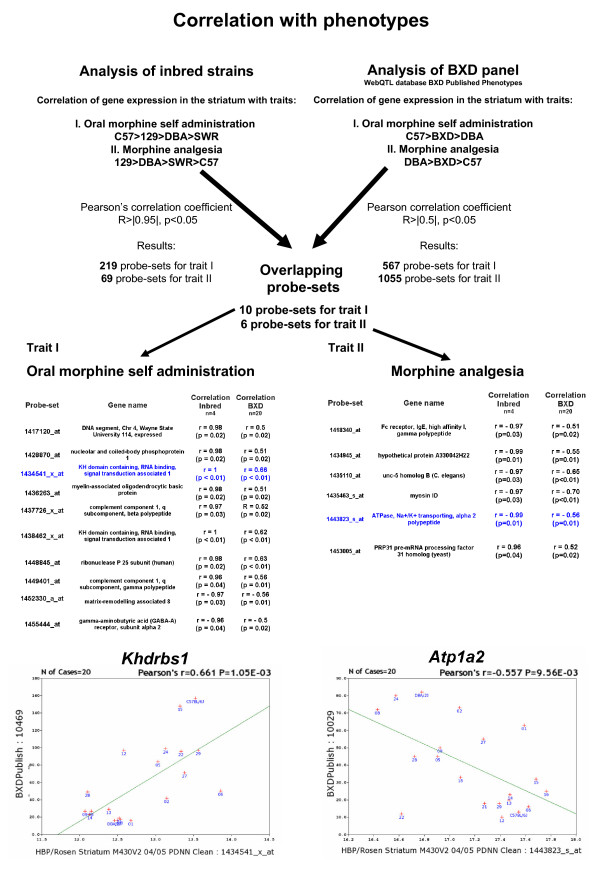
Correlation between opioid-related phenotypes and striatal gene expression. Comparison was performed using gene expression values of 1528 probe-sets significantly different between 129P3/J, DBA/2J, C57BL/6J and SWR/J strains [6]. Correlations between gene expression and morphine-related traits for RI BXD strains were computed using HBP/Rosen Striatum M430 v2.0 (Apr05) PDNN Clean dataset [69, 70]. All analyses were evaluated using the Pearson's correlation. Probe-sets overlapped in both analyses are presented in two tables on the left and right. Presented below scatterplots of correlation between expression values of two genes (Khdrbs1 and Atp1a2) emphasized in the table by blue colour and phenotypic data were generated by using WebQTL.